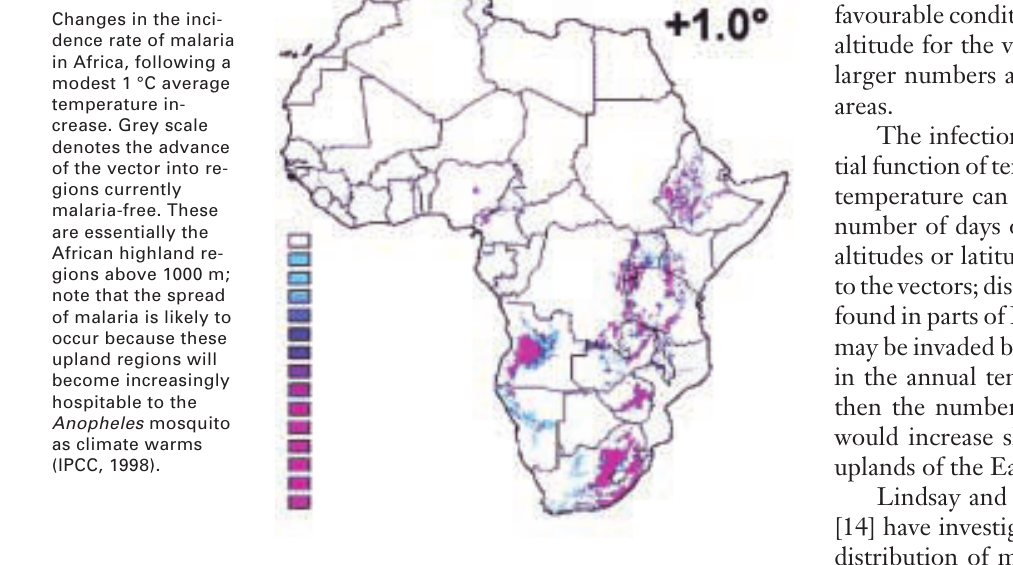
Infection rate in two African highland countries (Rwanda and Zambia), 1975–1990, according to Loevinsohn